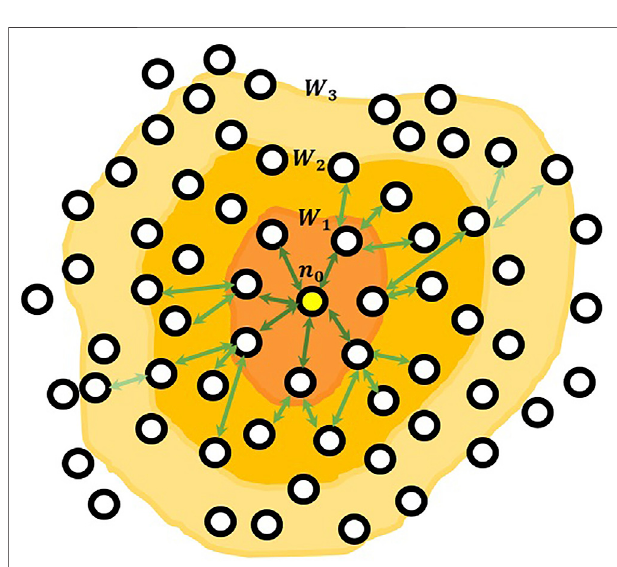
FIGURE 5 | Degree distribution of nodes with M and M 0 set to 4 for ER network with a network size of N = 1000